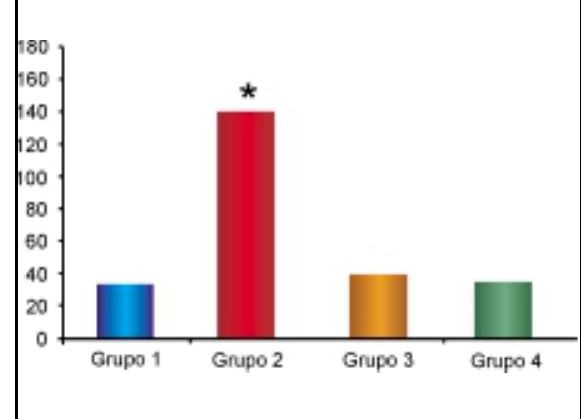
FIGURA 7 - Gráfico informando os valores da Alanina Aminotransferase (U/L). (* = p <